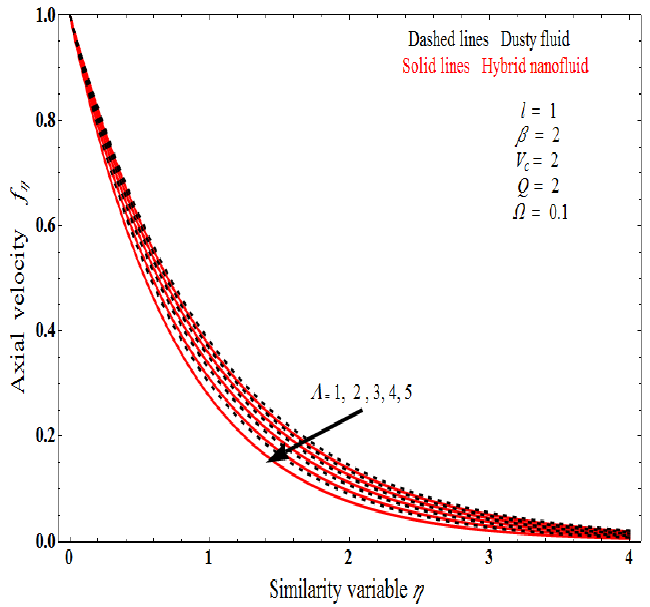
Figure 7. The impact of velocity profile on Brinkman number Λ .